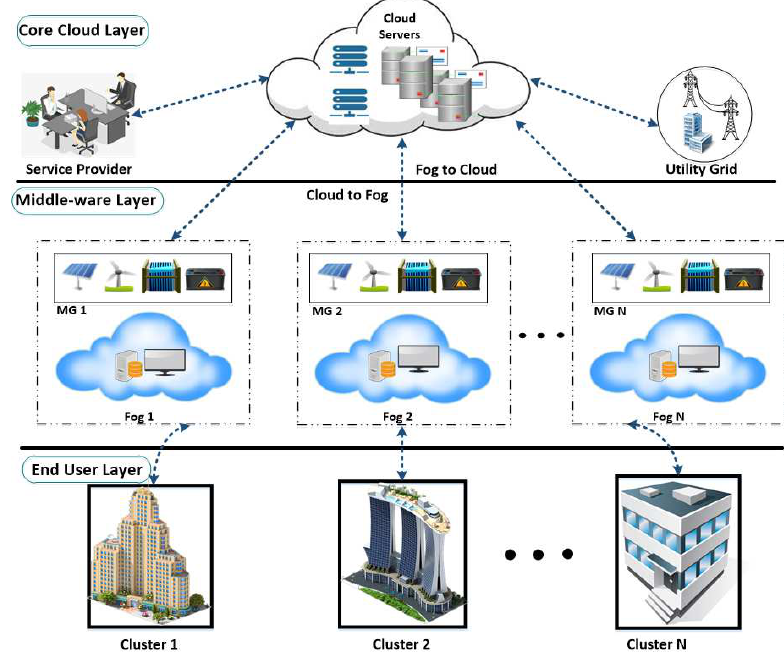
Figure 1. Pictorial View of Proposed System